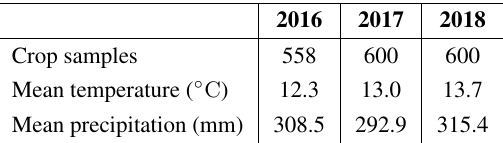
(highlighted in orange in Fig. 2) were averaged to provide an overview of the period March through July. While this does not reflect the entire region of Upper Bavaria, it is intended to provide an overview of the climatological conditions per Table 1. Data overview with average temperature and accumulated precipitation amount per year